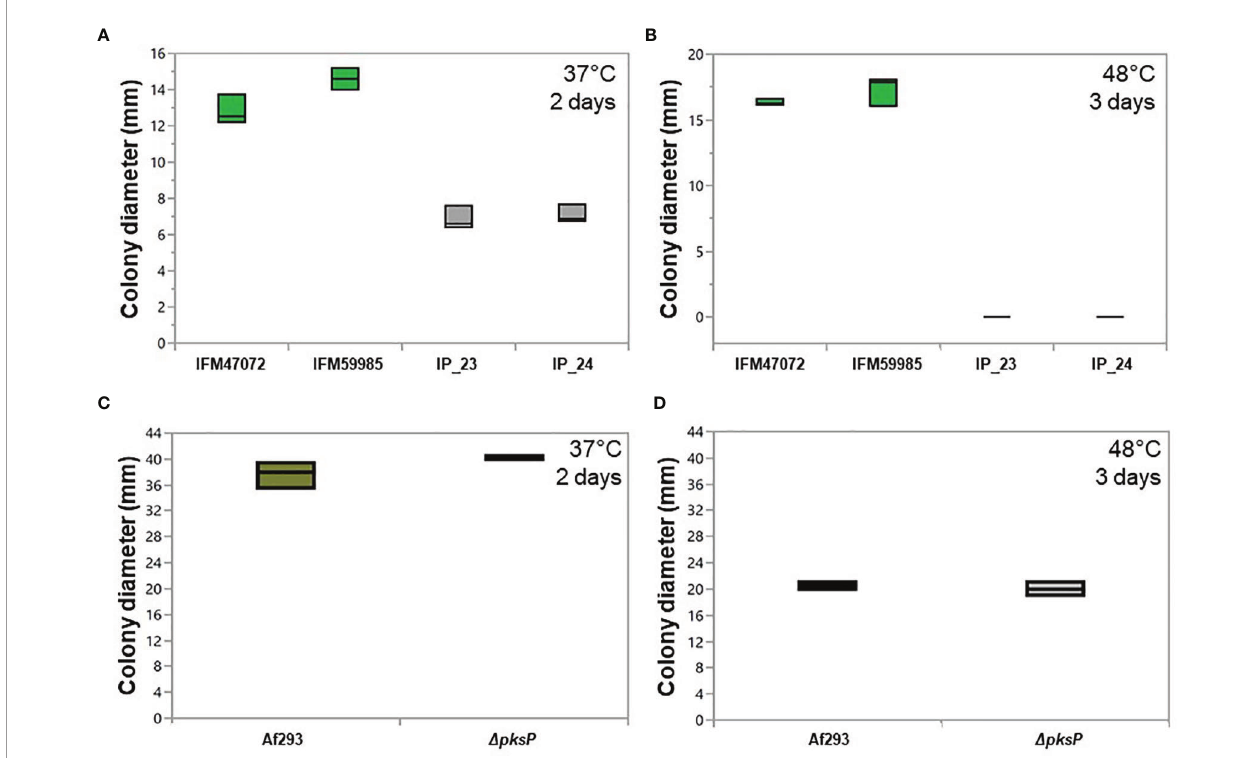
FIGURE 5 | Growth patterns of green-spore and white-spore isolates. Colony diameter of green-spore (green boxplot) and white spore (gray boxplot) isolates after growth at 37°C for 2 days (A) and 48°C for 3 days (B) . ~10 5 spores were inoculated in the center of minimal media plates, and colony diameter was measured at the end of the growth period. Each experiment was performed in triplicate. Green-spore isolates grew signi fi cantly faster than white-spore isolates at 37°C. White- spore isolates did not grow at 48°C. All statistical tests between green-spore and white-spore isolates (IP_23 vs. IFM47072, IP_23 vs. IFM59985 IP_24 vs. IFM47072 and IP_24 vs. IFM59985) were signi fi cant (all p-values ≤ 0.0001). Statistical tests between IP_23 vs. IP_24 and IFM47072 vs. IFM59985 were not signi fi cant (p-values > 0.09). Colony diameter of Af293 (green boxplot) and D pksP (null mutant) (white boxplot) at 37°C for 2 days (C) and 48°C for 3 days (D) . D pksP growth rate was not signi fi cantly different than Af293 at 37°C (p-value = 0.15) or 48°C (p-value =